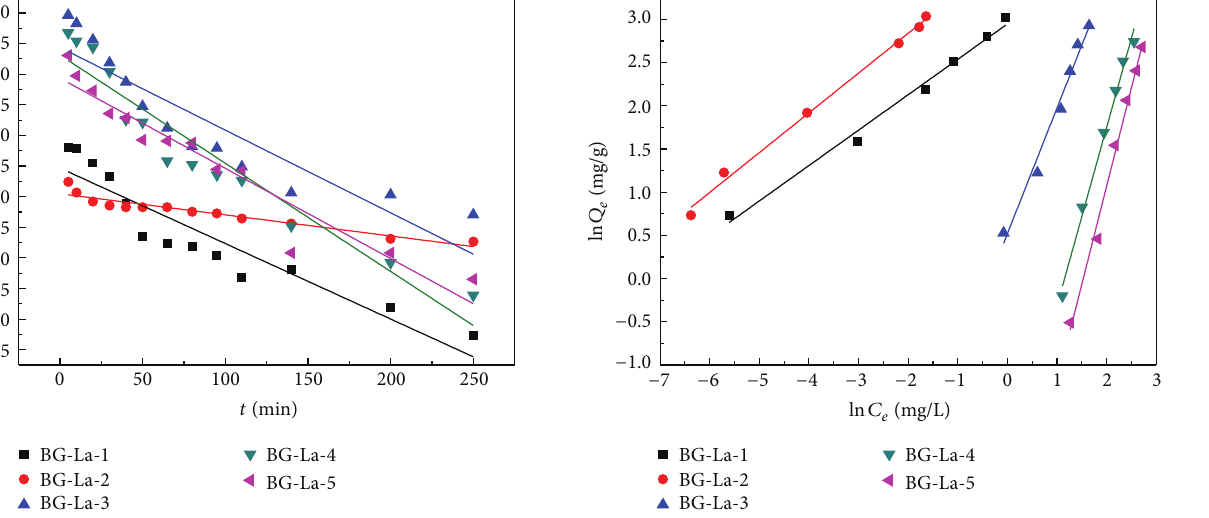
Figure 10: The Freundlich isotherm of MB on BG-La.